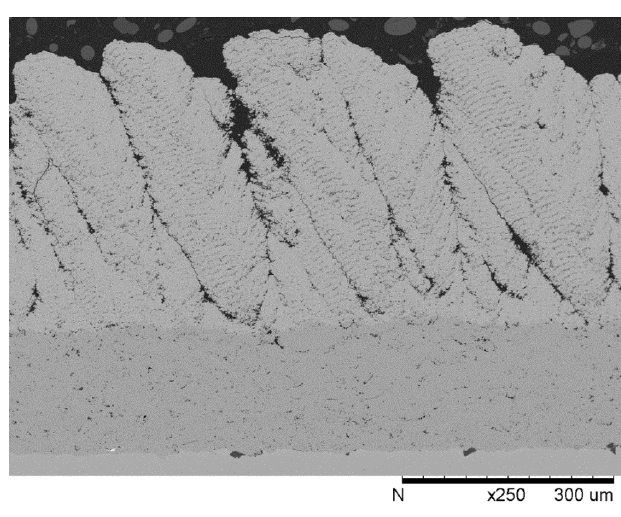
Figure 7. C1 coating, 400 nm